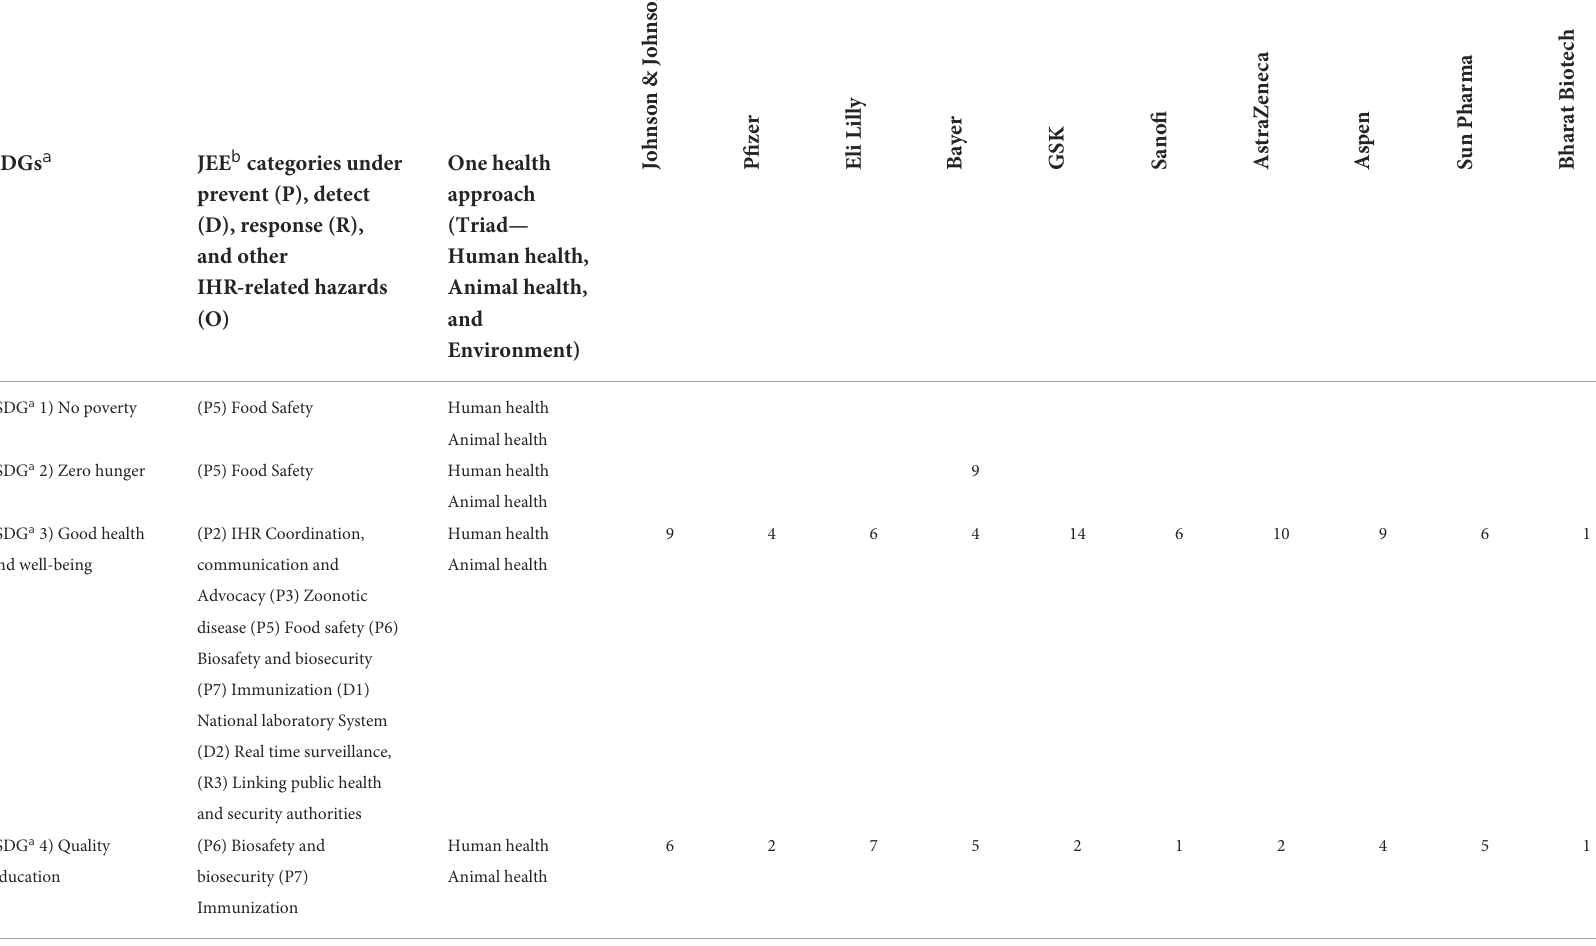
TABLE 4 Activities under 17 sustainable development goals, joint external evaluation, and one health for the year 2019–2020, sustainable development goals, one health, India, 2019–2021.